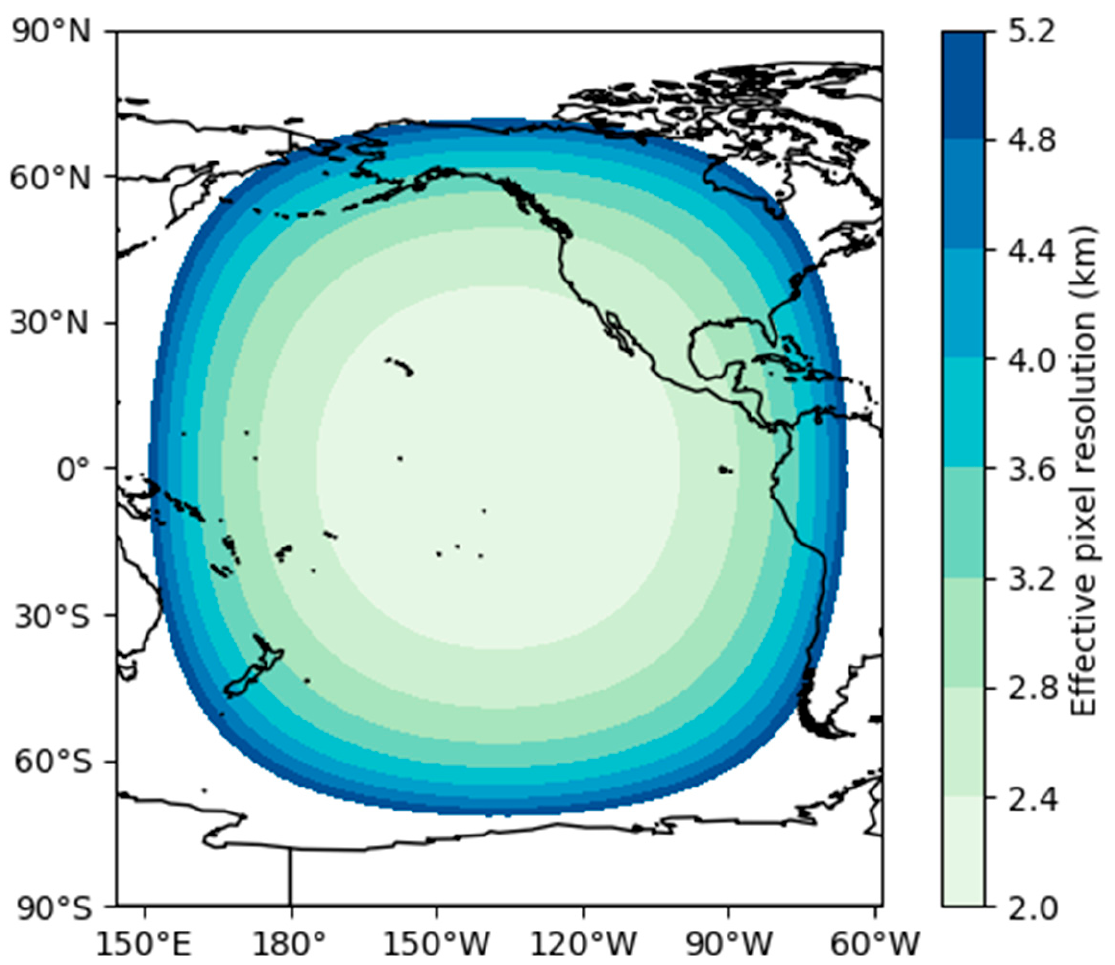
Figure 3. The distribution of projected effective super-pixel resolution in a GOES-17 ABI full-disk image.